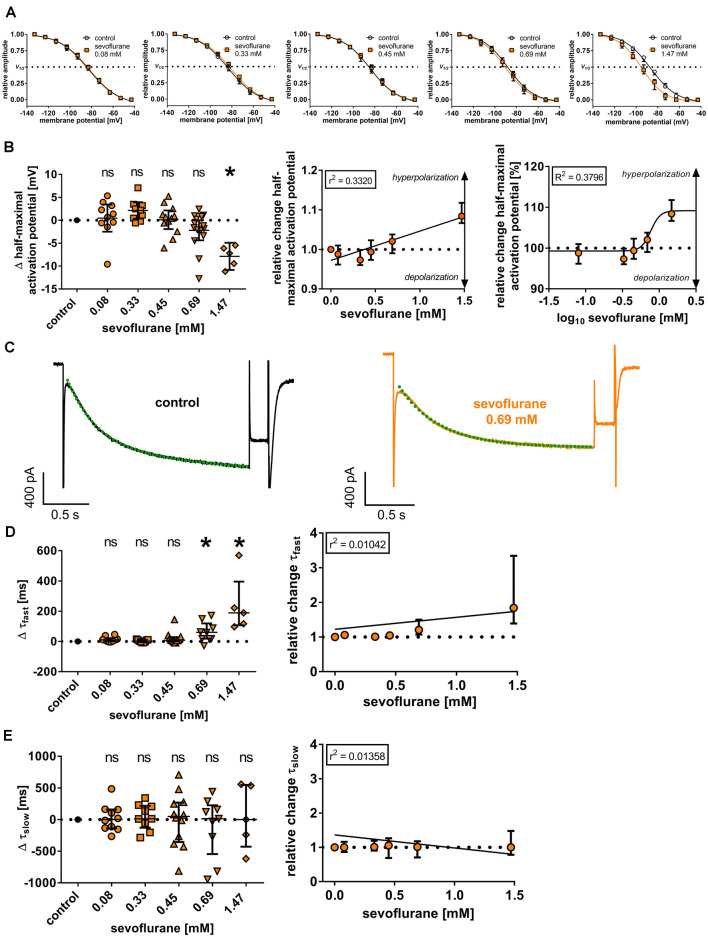
(A) Normalized tail currents (Itail) were fitted to a curve using a Boltzmann function to analyze voltage-dependent channel gating under control conditions and in the presence of increasing concentrations of sevoflurane. V1/2: half-maximal activation voltage. (B) In a concentration range of 0.08 mM to 0.69 mM, we did not observe a change of the half-maximal activation voltage [control: −85.6 (−88.2 to −83.2) mV, n = 51], only 1.47 mM sevoflurane significantly shifted the half-maximal activation voltage towards hyperpolarization. Using linear regression analysis and non-linear regression analysis, the shift towards hyperpolarization was concentration-dependent. Δ: absolute change compared to control. ns, not significant. *p < 0.05. (C) Representative Ih current traces at −133 mV under control conditions and after applying 0.69 mM sevoflurane. Activation kinetics of Ih were acquired by fitting a biexponential function to the Ih current at −133 mV, resulting in a fast (τfast) and a slow (τslow) time constant of time-dependent activation. The biexponential curve fitting is visualized with green dotted lines. (D) Higher concentrations of 0.69 mM and 1.47 mM resulted in a significant prolongation of τfast [control: 218 (183–256) ms, n = 45], whereas no statistically significant differences concerning τslow [control: 1,091 (979–1,373) ms, n = 45] were observed (E). In both cases, changes were not concentration-dependent.